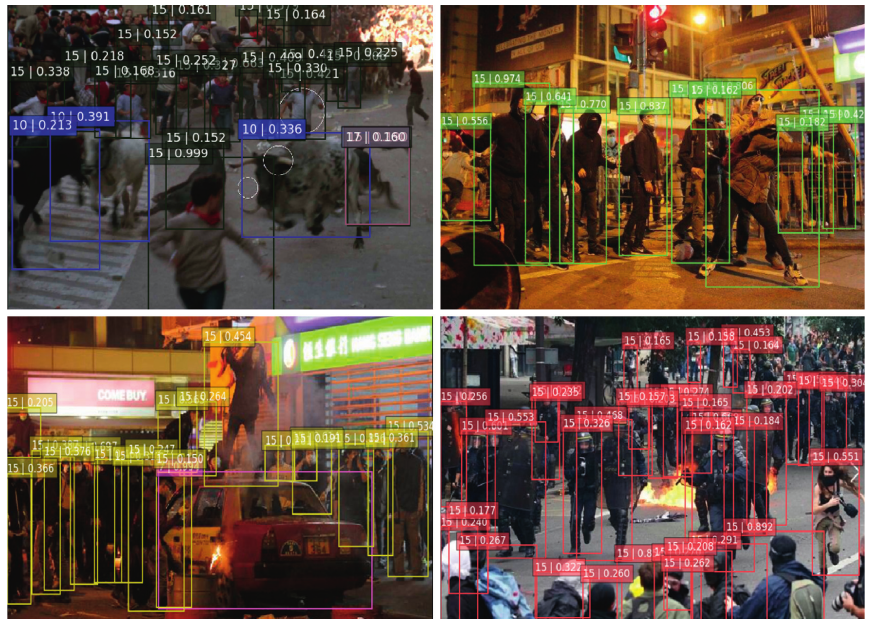
Figure 11: Test results of some abnormal data. Table 2: Comprehensive test